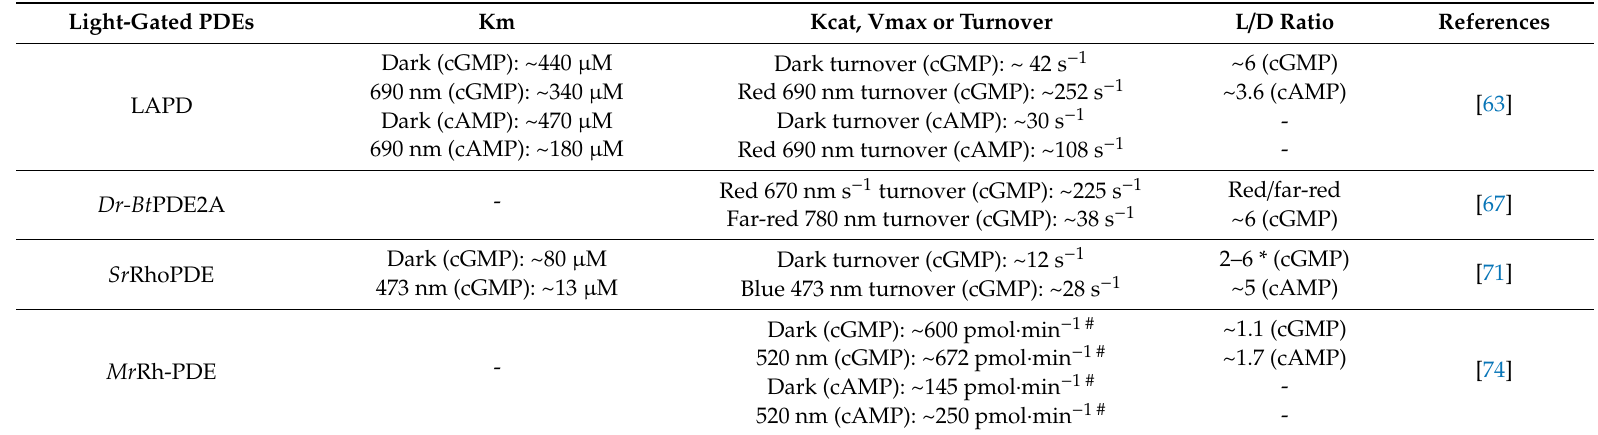
Table 1. Comparison of Km, Kcat, and dynamic range of light-gated